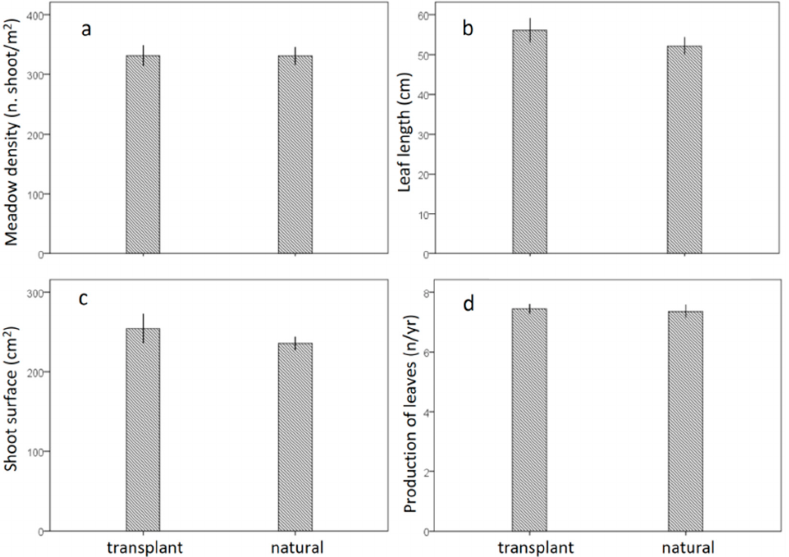
Figure 6. Mean values (SE) of meadow density ( a ), leaf length ( b ), shoot surface ( c ) and number of leaves produced ( d ) in transplanted and natural beds.